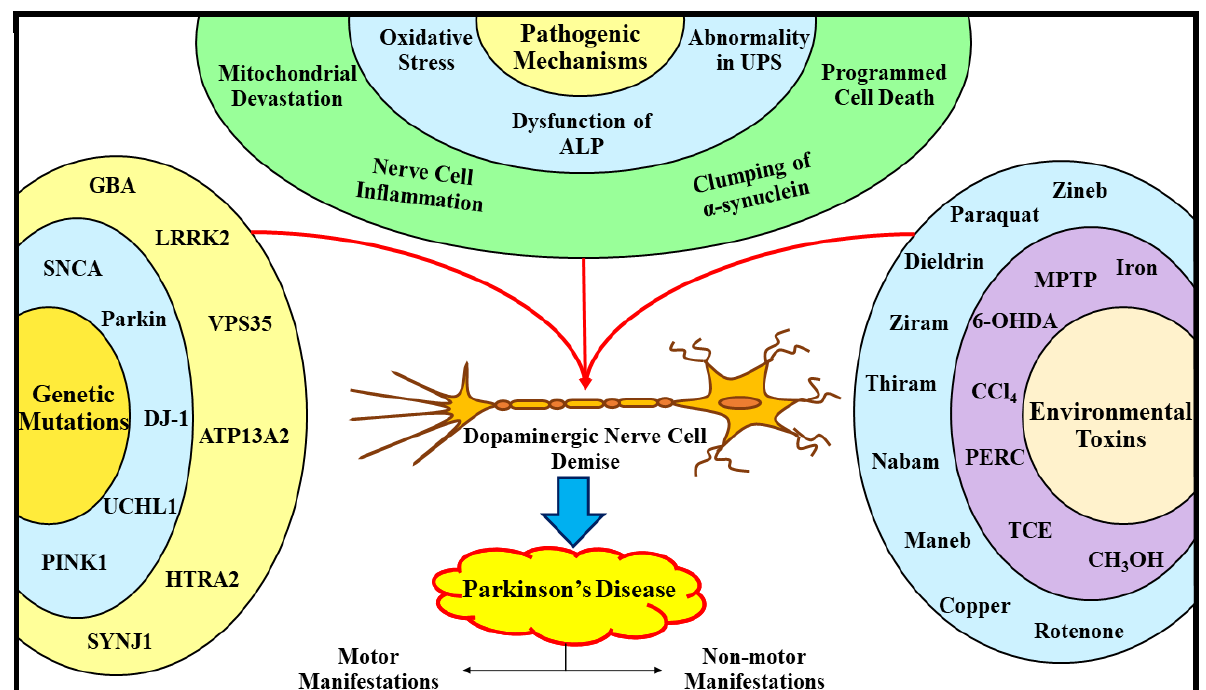
Figure 2. Portraying the active participation of genetic mutations, environmental toxins, and pathogenic processes in the progression/evolvement of Parkinson’s disease. The trio, namely genetic mutations ( SNCA , Parkin , DJ-1, UCHL1 , PINK1 , GBA , LRRK2 , VPS35, ATP13A2, HTRA2, and SYNJ1), subjection to environmental toxins (MPTP, 6-OHDA, CH 3 OH, PERC, TCE, CCl 4 , zineb, paraquat, rotenone, dieldrin, ziram, thiram, nabam, maneb, copper, and iron), and pathogenic mechanisms (oxidative stress, dysfunction of ALP, abnormality in UPS, mitochondrial devastation, nerve cell inflammation, clumping of α -synuclein, and programmed cell death), give rise to dopaminergic nerve cell demise, which as a result culminates in the progression/evolvement of PD. SNCA , α -synuclein; Parkin , Parkin RBR E3 ubiquitin–protein ligase ; DJ-1, protein deglycase; UCHL1 , ubiquitin carboxy (C) -terminal hydrolase L1 ; PINK1 , PTEN-induced kinase 1 ; GBA , glucocerebrosidase; LRRK2 , leucine-rich repeat kinase 2 ; VPS35, vacuolar protein sorting 35; ATP13A2, neuronal P-type adenosine triphosphate (ATP)ase gene; HTRA2, high temperature requirement A2; SYNJ1, synaptojanin 1 ; MPTP, 1-methyl-4-phenyl-1,2,3,6-tetrahydropyridine; 6-OHDA, 6-hydroxy DA; CH 3 OH, methanol; PERC, perchloroethylene; TCE, trichloroethylene; CCl 4 , carbon tetrachloride; ALP, autophagy lysosomal pathway; UPS, ubiquitin-proteasome system; PD, Parkinson’s